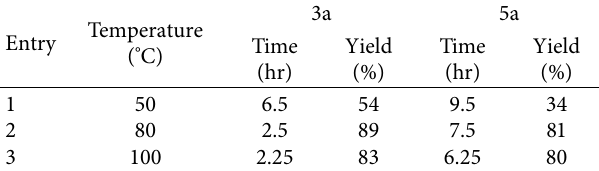
Table 4: Screening of optimum temperature.